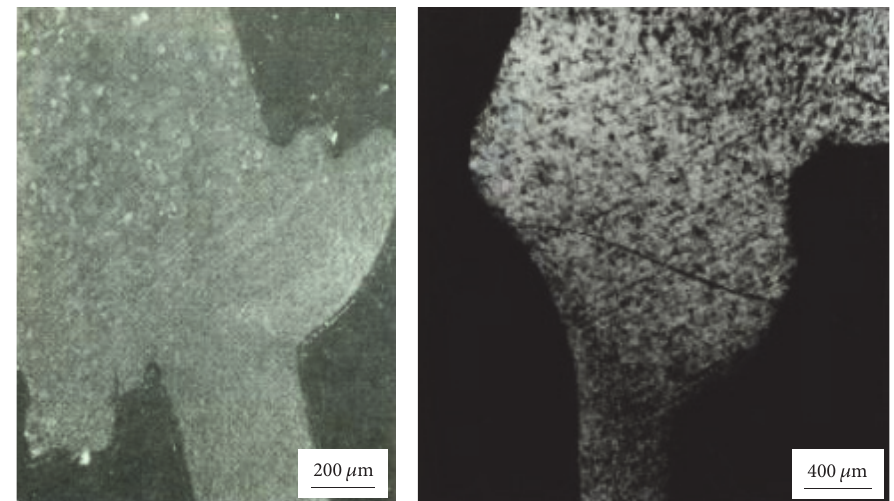
Figure 7: Weld shape after resistance welding.